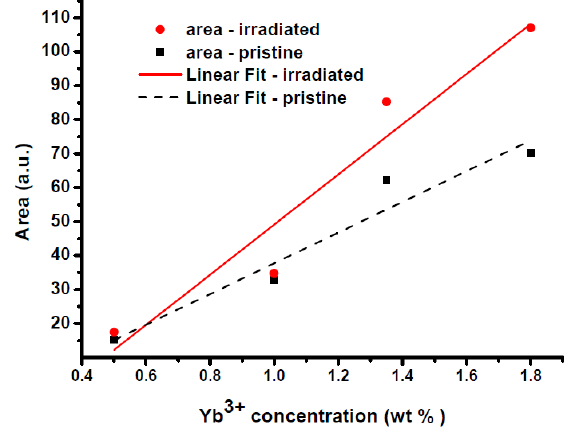
Figure 2. Area under UV band as a function of Yb 3+